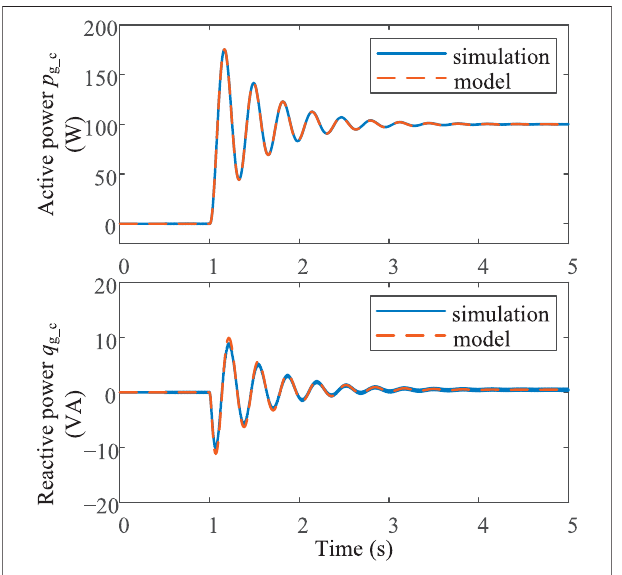
FIGURE 8 | Active and reactive power responses of the small-signal model andsimulationofthedroop-controlledconvertersundera100 Wstep- up active power reference change.